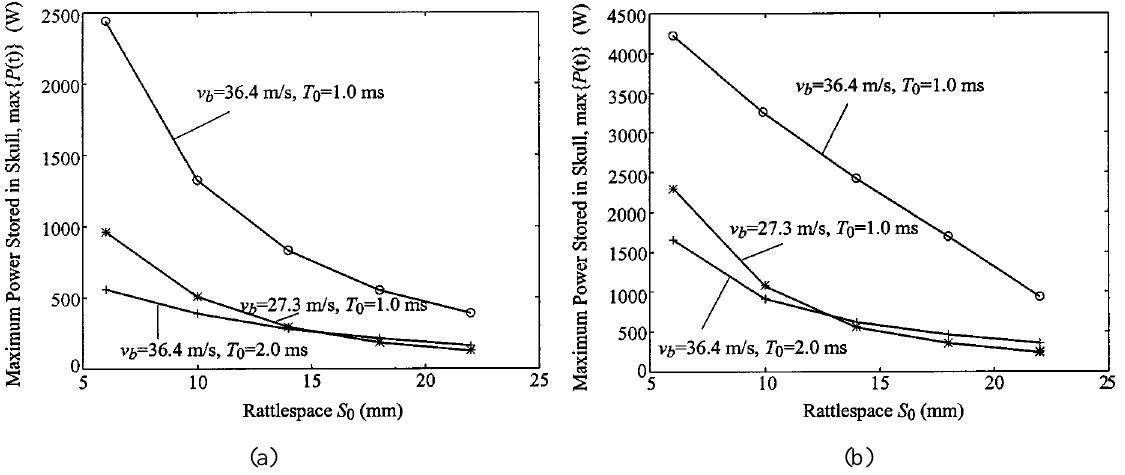
Fig. 17. The trade-off curves for Case 3 (minimization of the peak power developed in the skull): (a) Front impact: A–P direction, (b) Side impact: L–R